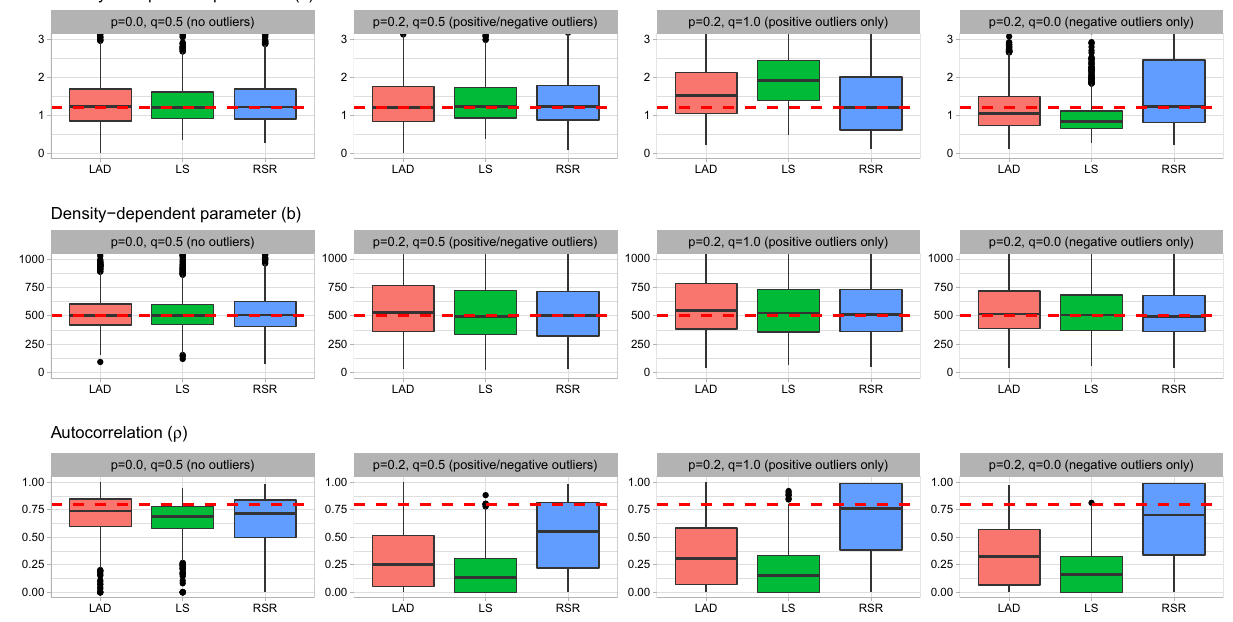
Figure 3. Parameter estimates of the density-independent parameter ( a ), density-dependent parameter ( b ), and autocorrelation ( ρ ) for the simulation using the HS SR function with autocorrelation (true ρ